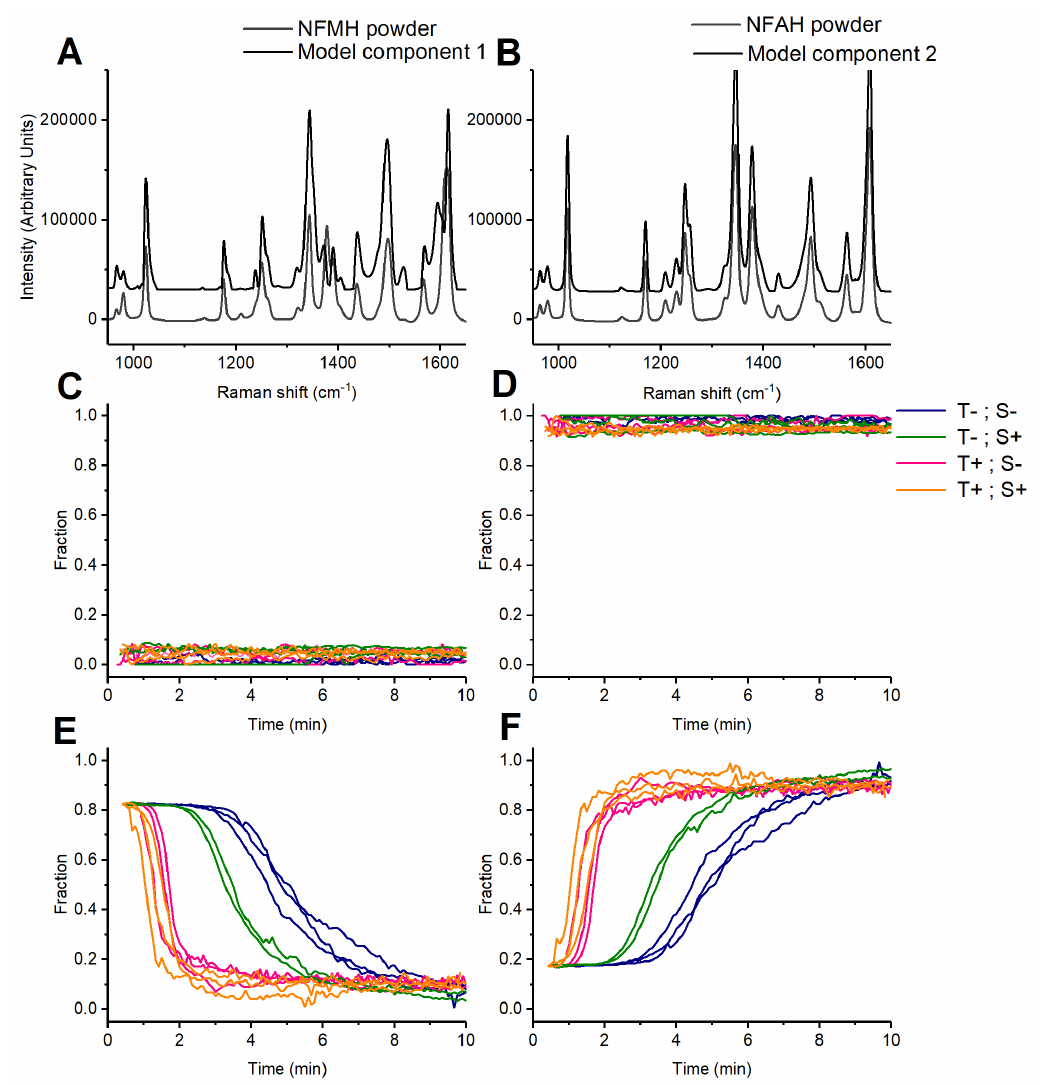
Figure 3. Loadings and score values (relative fraction) of a 2-component MCR model of the NF dataset collected during extrusion at different process conditions, ( A ) and ( B ) Loadings of component 1 and 2 (black) against NFMH powder and NFAH powder (gray), respectively; ( C ) score values of NFAH-PEO samples on component 1, ( D ) score values of NFAH-PEO samples on component 2, ( E ) score values of NFMH-PEO samples on component 1 and ( F ) score values of NFMH-PEO samples on component 2. Process conditions indicated with colors T−: 70 °C, T+: 90 °C, S−: 25 rpm and S+: 50 rpm.